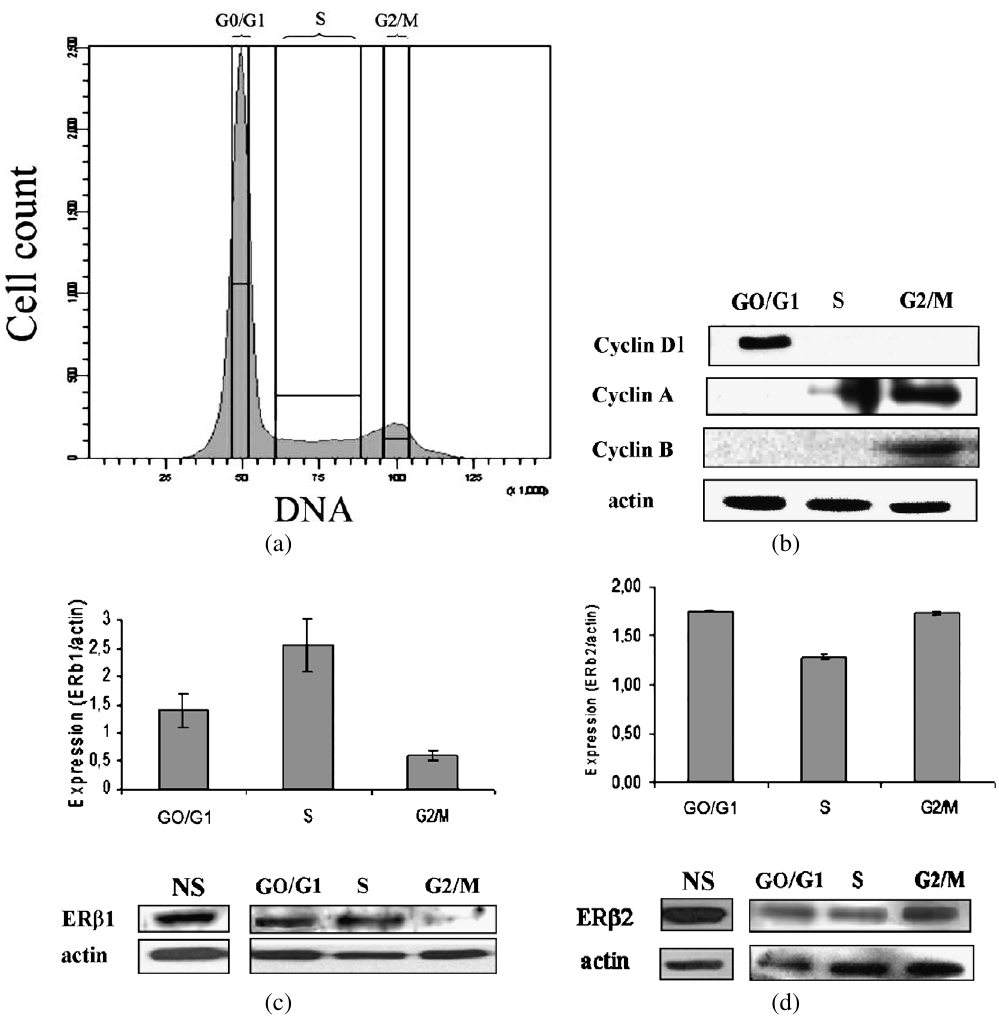
Fig. 2. ER β protein expression in isolated cells at specific cell-cycle phases by flow cytometric cell sorting. (a) Cell cycle profile of asynchronous LNCaP cells stained with propidium iodide and analyzed by flow cytometry. Windows define the limits used to isolate the G0/G1, S and G2/M cell populations. (b) Western blot analysis of cyclin D1, cyclin A and cyclin B expression as specific markers for the G0/G1, S and G2/M phases respectively, in protein extracts of sorted LNCaP cells at each cell cycle phase. (c and d) Western blot analysis of ER β 1 and ER β 2 expression in LNCaP cells sorted at each phase of the cell cycle and in non-sorted (NS) cells (used as positive control). Protein levels of ER β 1 increased from G1 to S and decreased before entering the G2/M phase, whereas ER β 2 levels decreased during the S phase and increased again in the G2/M